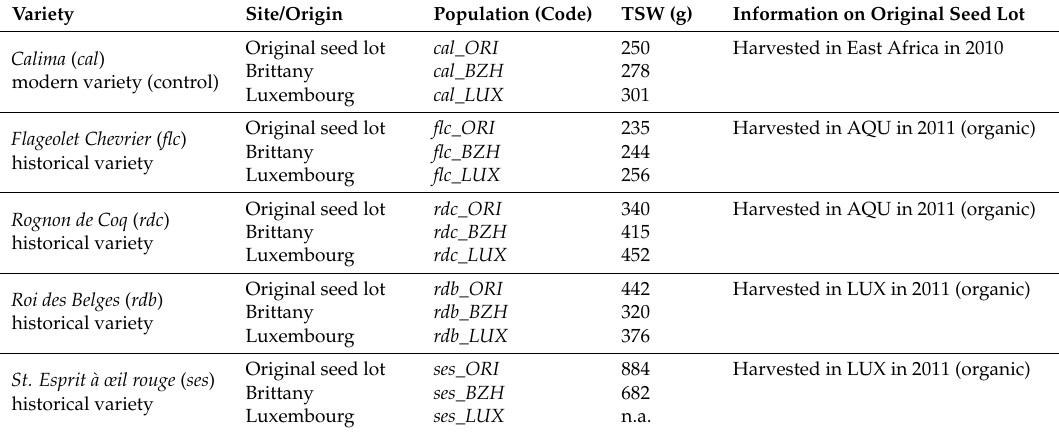
Table 1. Different populations of historical and modern bean varieties developed and assessed in the experiment. The 1000-seed weight (TSW) of each seed lot is also